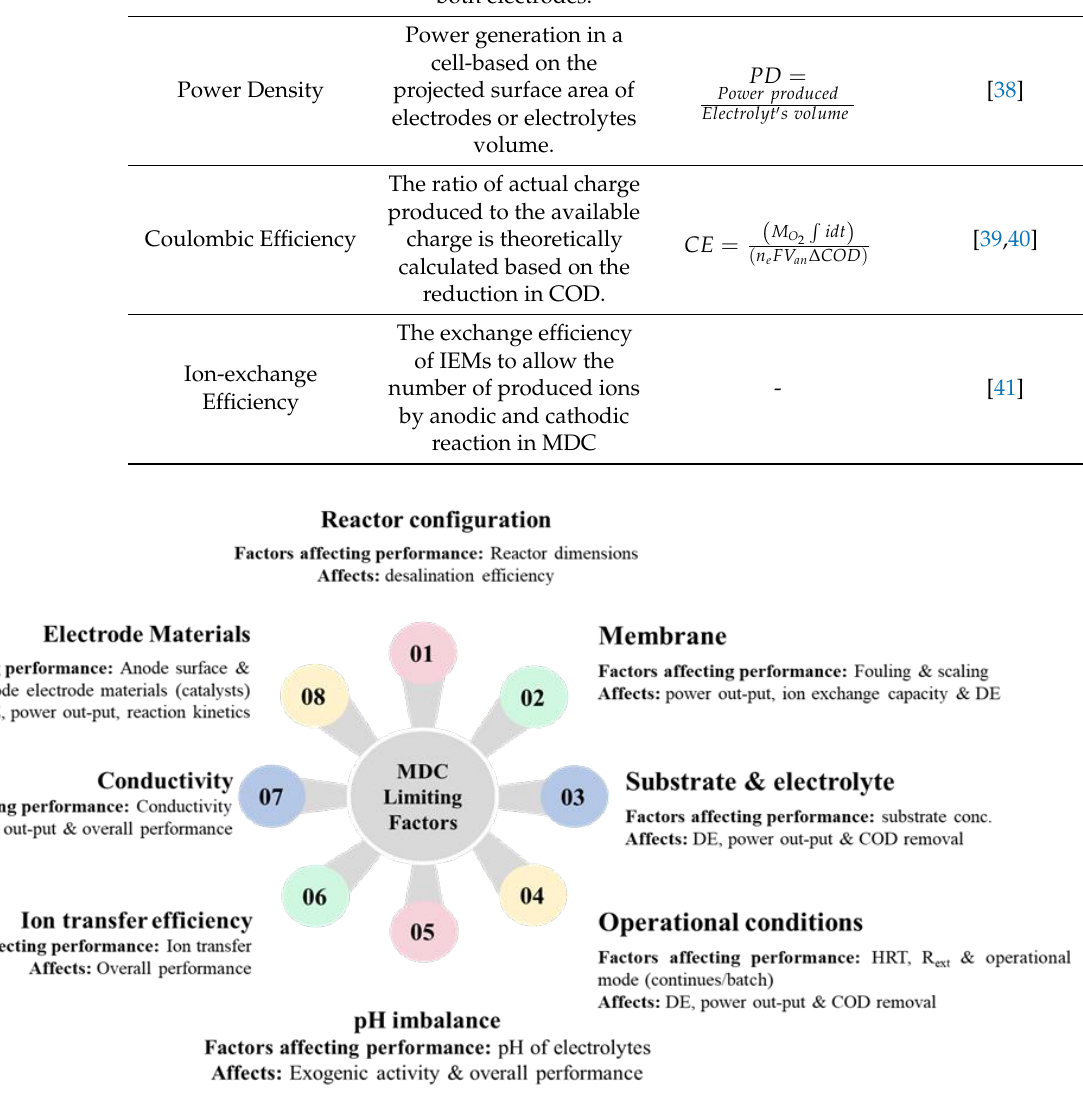
Figure 2. Limiting factors of MDC performance. Table 1 . MDC performance and efficiency indications.